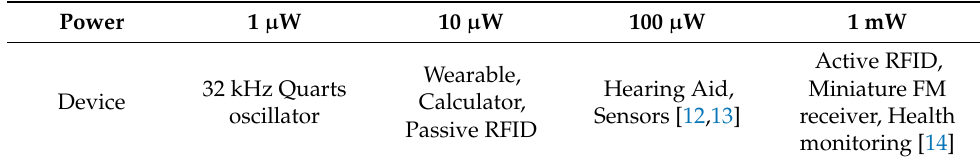
Table 1. The typical range of the power consumption of various electronic devices [15,16].